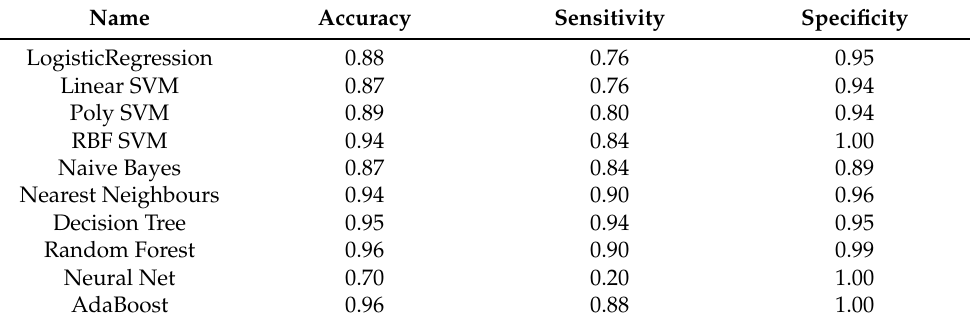
Figure 4. Classifier decision surface plotted for selected classifiers in dimension of two T-distributed stochastic neighbour embedding components. The achieved accuracy of classification for each specific case is shown in the yellow box in the right bottom corner. Table 2. Accuracy, sensitivity and specificity for UMAP and all tested combinations of shallow learning